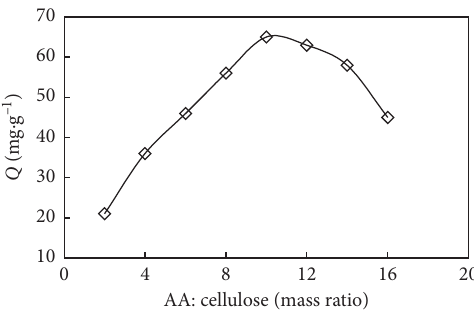
Figure 4: Effects of monomer on Cu 2+ absorption capability.